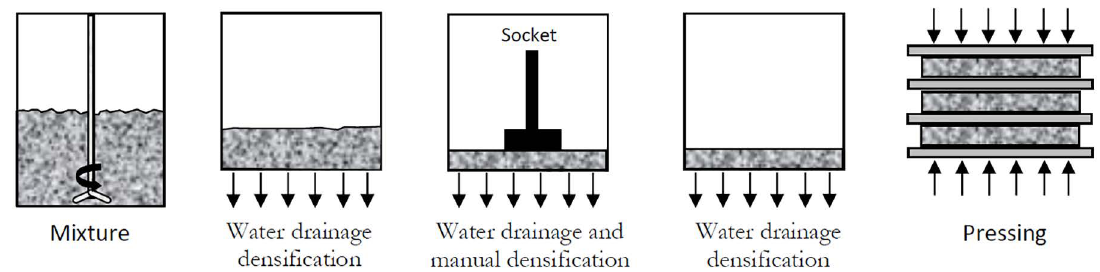
Figure 1. Sketch showing the mixing and moulding of the